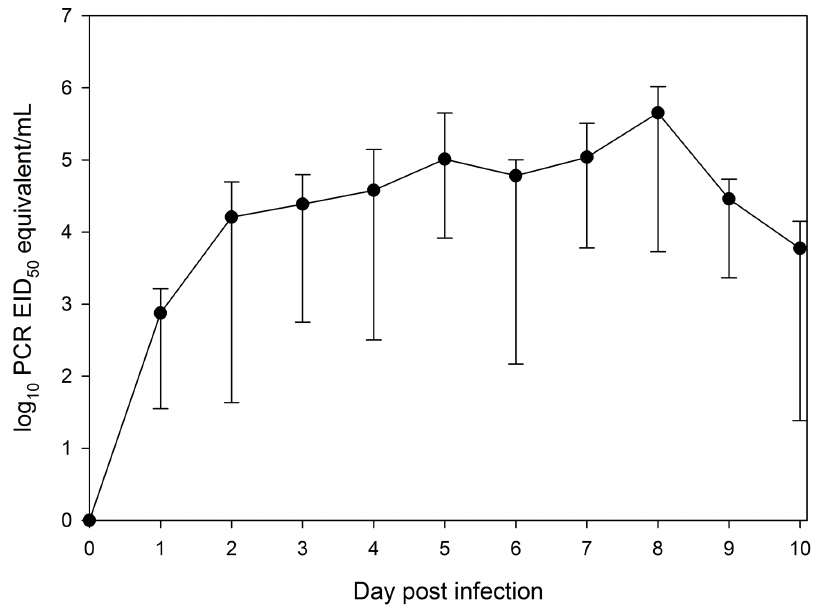
Figure 1. Mean nasal shedding of avian influenza virus RNA of striped skunks ( Mephitismephitis ) experimentally infected with a low-pathogenic avian influenza virus. Shedding was assessed from nasal washes by RRT-PCR. Results are presented as log 10 PCR EID 50 equivalents/mL. Vertical bars represent the maximum and minimum quantities detected on a given day.